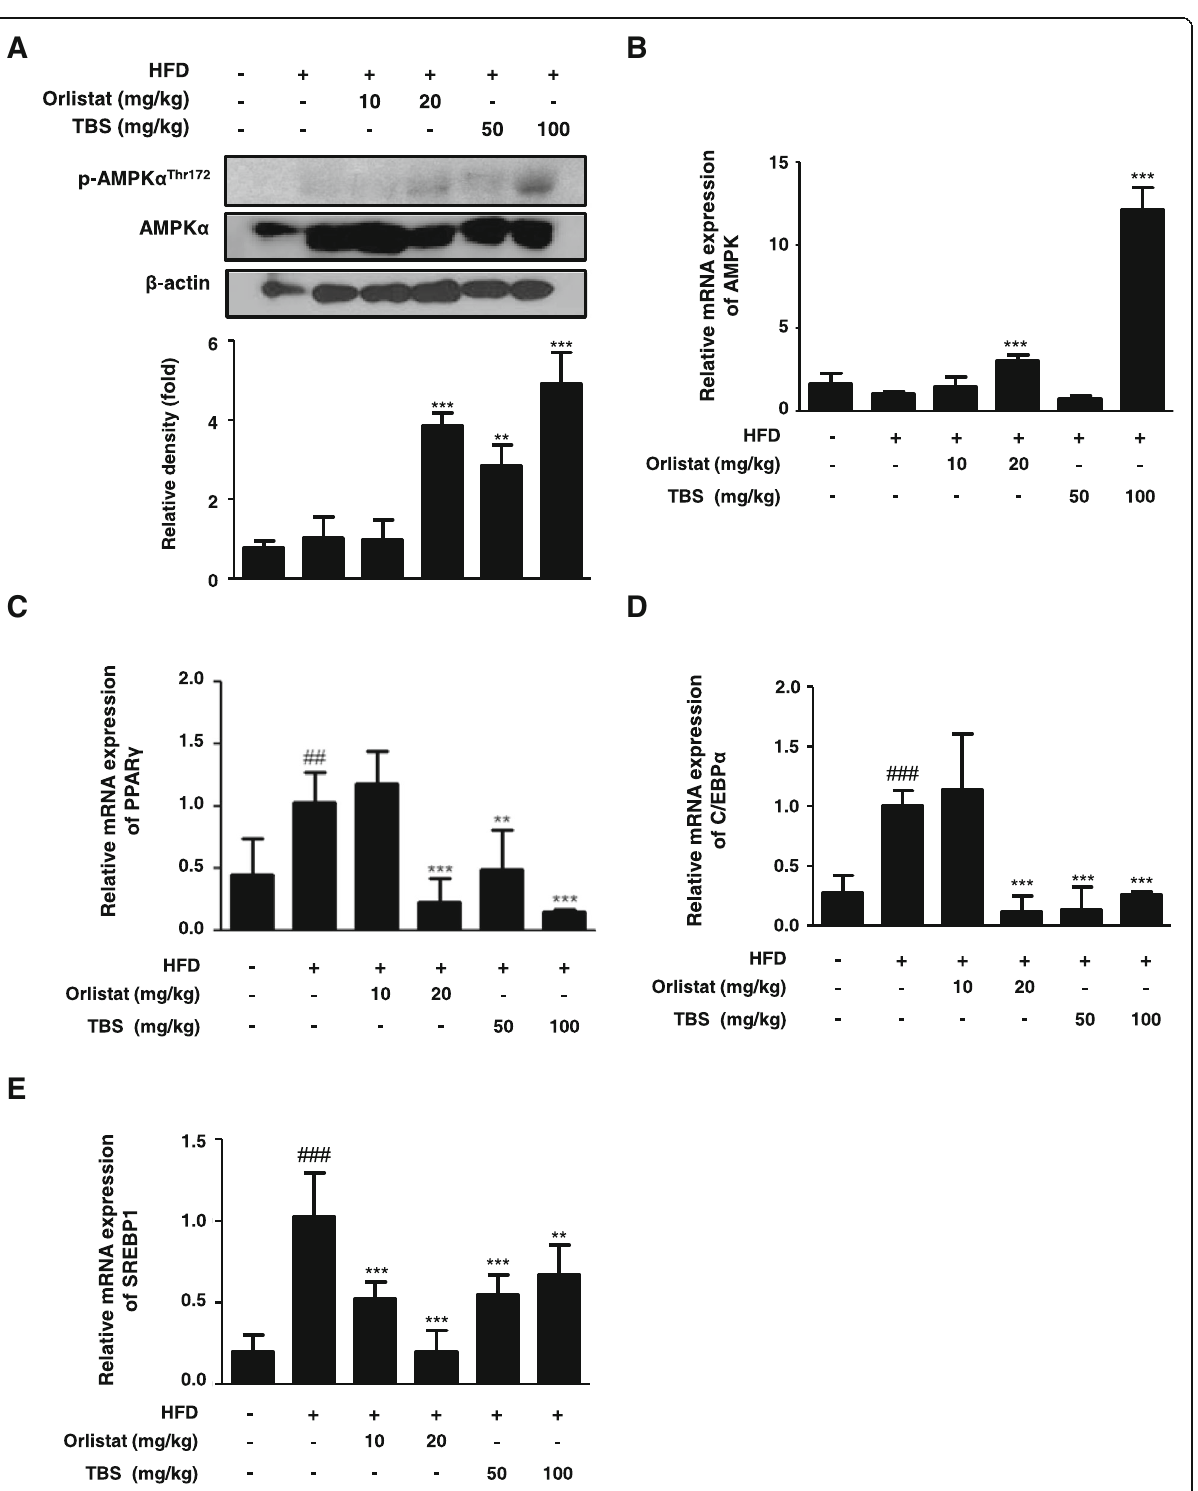
Fig. 4 Effects of TBS on AMPK, PPAR γ , C/EBP α , and SREBP1 mRNA expression in epididymal white adipose tissue. Total protein and RNA were prepared from epididymal white adipose tissue (WAT), and the protein expression of ( a ) p-AMPK and the mRNA levels of ( b ) AMPK, ( c ) PPAR γ , ( d ) C/EBP α , and (E) SREBP1 were determined by western blot analysis and quantitative RT-PCR (qRT-PCR). Densitometric analysis was performed using ImageJ ver. 1.50i. The values represent the mean±S.D. of three independent experiments. ## p <0.01 and ### p <0.001 vs. the control group; ** p <0.01 and *** p <0.001 vs. HFD